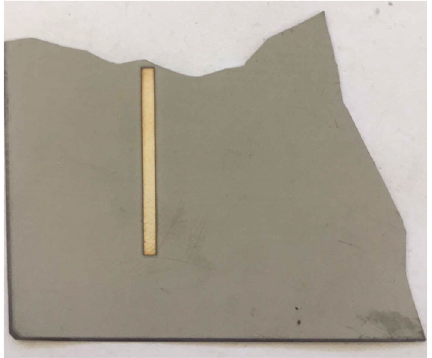
Figure 2: Bottom aluminium layer of solar